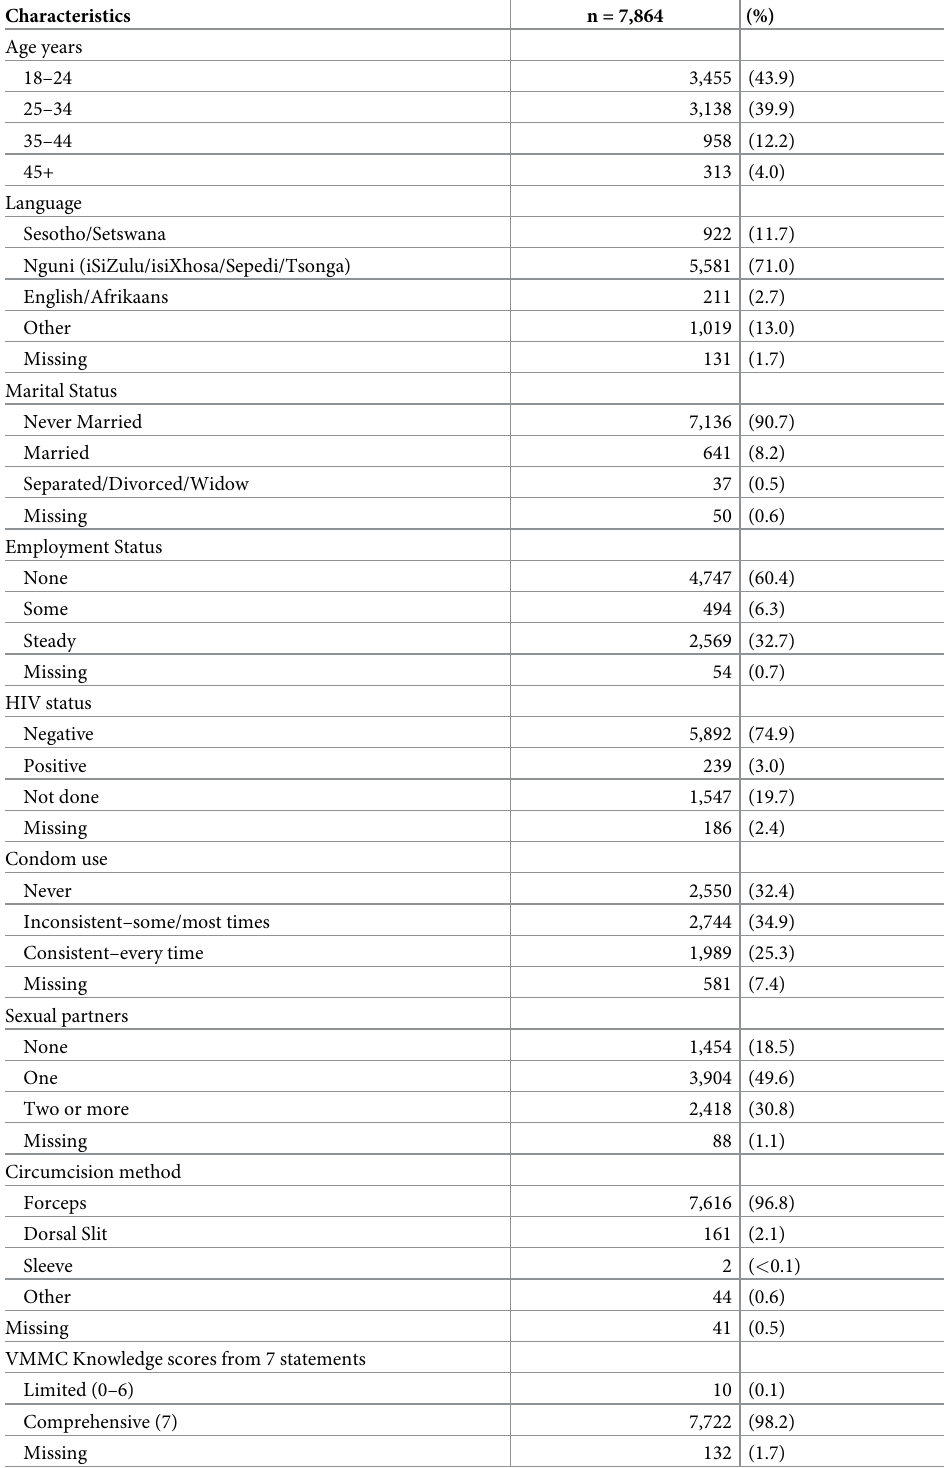
Table 1. Baseline characteristics of adult men presenting for a circumcision programme implemented in Gauteng and North West provinces of South Africa